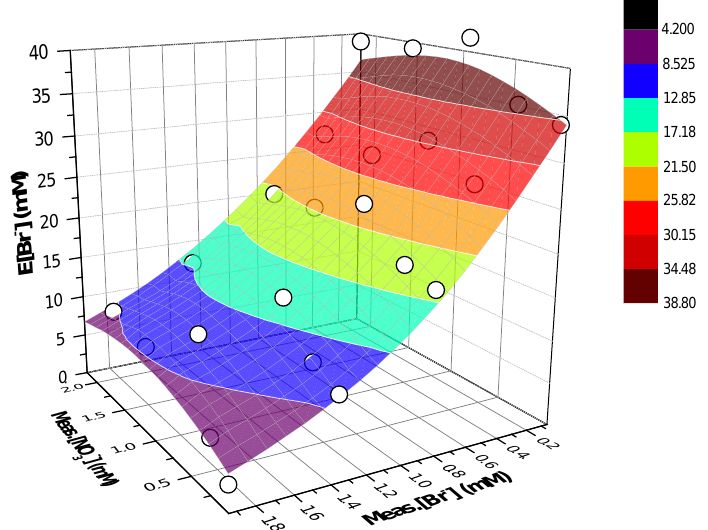
Figure 4. Three-dimensional ( 3D) surface fitting the experimental data (white points) as triads (x, y, z) = (Meas.[NO 3 − ], Meas.[Br − ], E[Br − ]). Eluent 1 mM NaHCO 3 –3.2 mM Na 2 CO 3 . Integration of the peaks as shown in Figure 1.